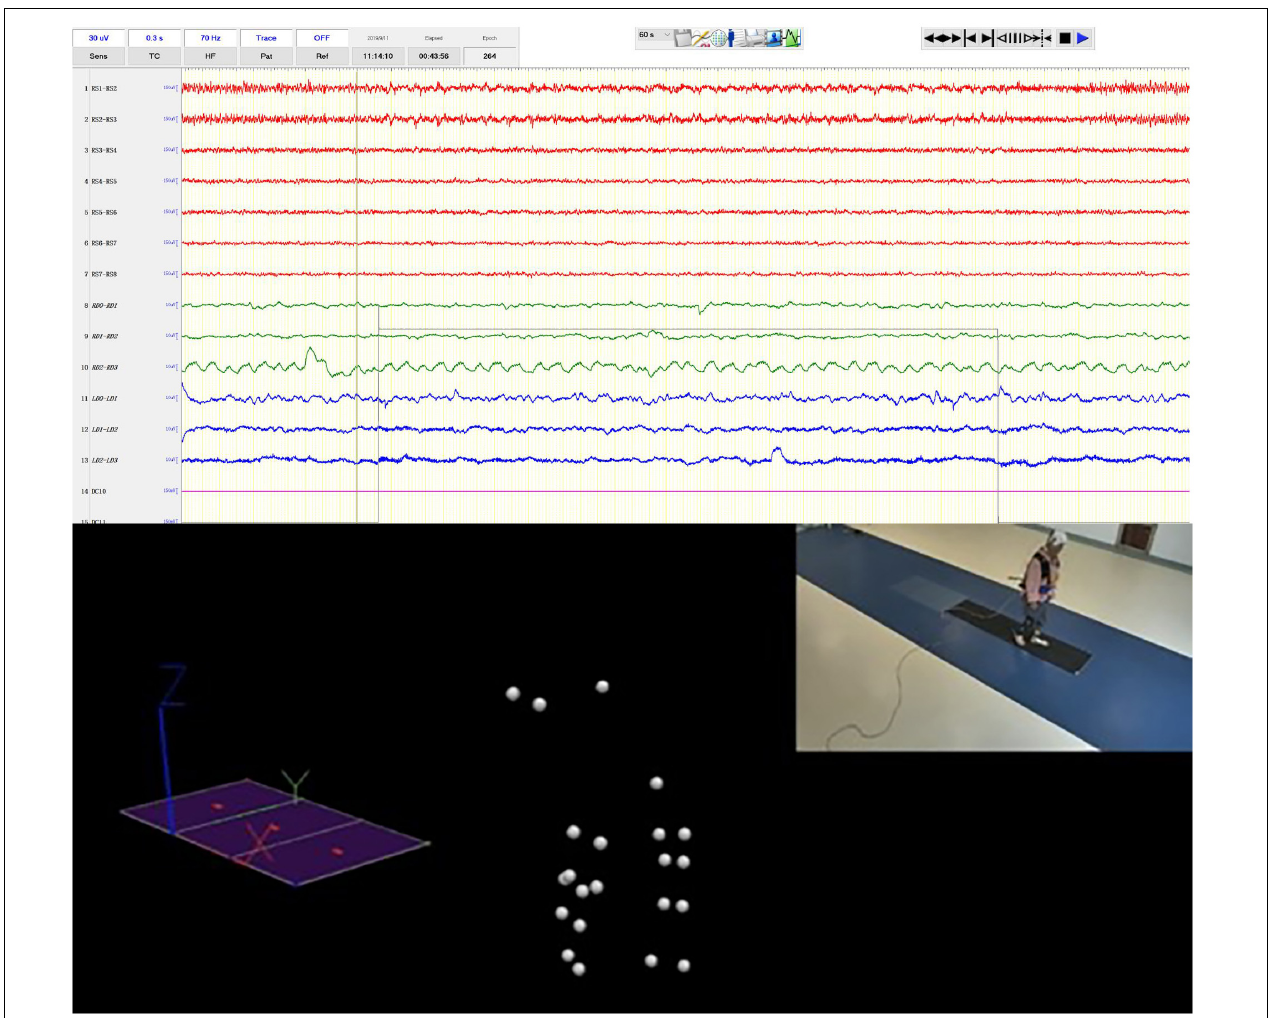
FIGURE 1 | Syncronized iEEG recording and motion capture. The video clip in the upper right was simultaneously recorded by the video-EEG and real-time spatial positions of the optical sensitive nodes weared by the patients were captured by multiple surrounding